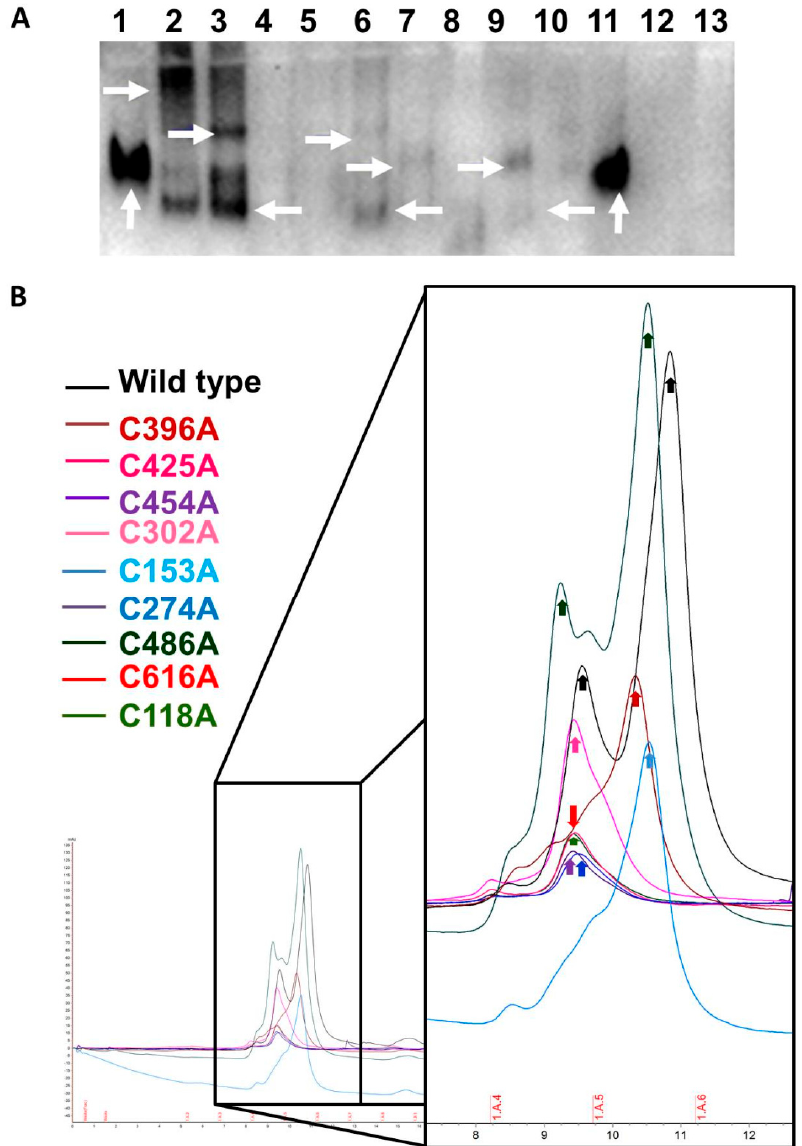
Figure 3. Altered complexation / Oligomerization of FXIII-B Cys mutants. Panel A . Western blot of rFXIII-B cysteine mutants after separation by native PAGE which were found to be secreted successfully (as detected by ELISA). Lanes: 1: Wild-Type; 2: C153A; 3: C118A; 4: C180A; 5: C267A; 6: C274A; 7: C396A; 8: C425A; 9: C454A; 10: C616A; and 11: rFXIII-B (Zedira, 75ng); 12: C302A. Vertical white arrows represent the Wild-type and rFXIII-B (Zedira GmbH, Darmstadt, Germany), whereas horizontal white arrows here indicate the diverse mobility of protein bands corresponding to FXIII-B (since the western blot has been probed with the mouse to human FXIII-B antibodies) Panel B. Gel-filtration chromatography of purified FXIII-B cysteine mutants. Color codes represent respective mutants indicated as inset in the figure. The x-axis denotes retention volume [ml], and the y-axis represents the amount of protein in mAU (UV-280nm).